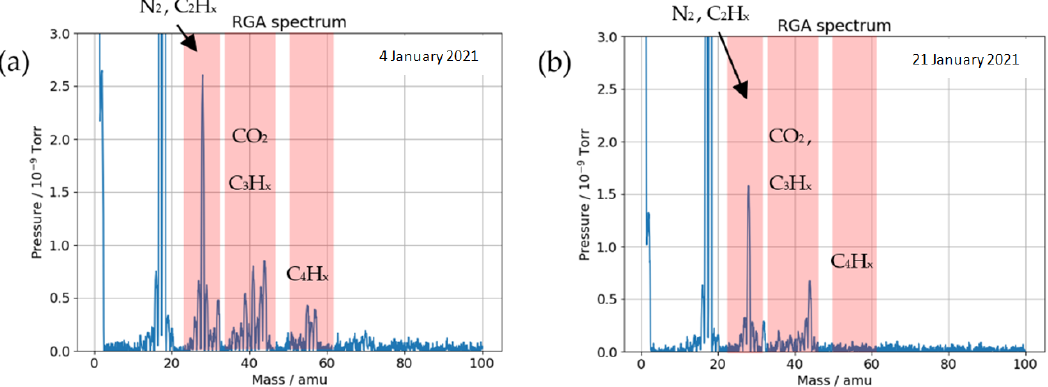
Figure 14. Residual gasses’ composition in DiFU chamber in: ( a ) intact chamber and ( b ) with all carbon mitigation procedures applied.